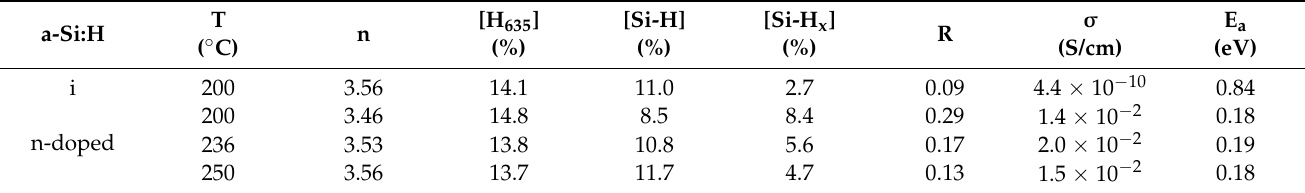
Table 2. Optical, electrical and structural properties of a-Si:H(n) and a-Si:H(i) films deposited by PECVD.